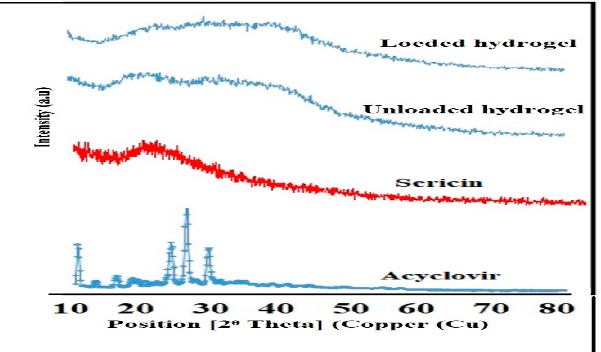
Figure 8. XRD model of Acyclovir, Sericin, unloaded, and drug-loaded